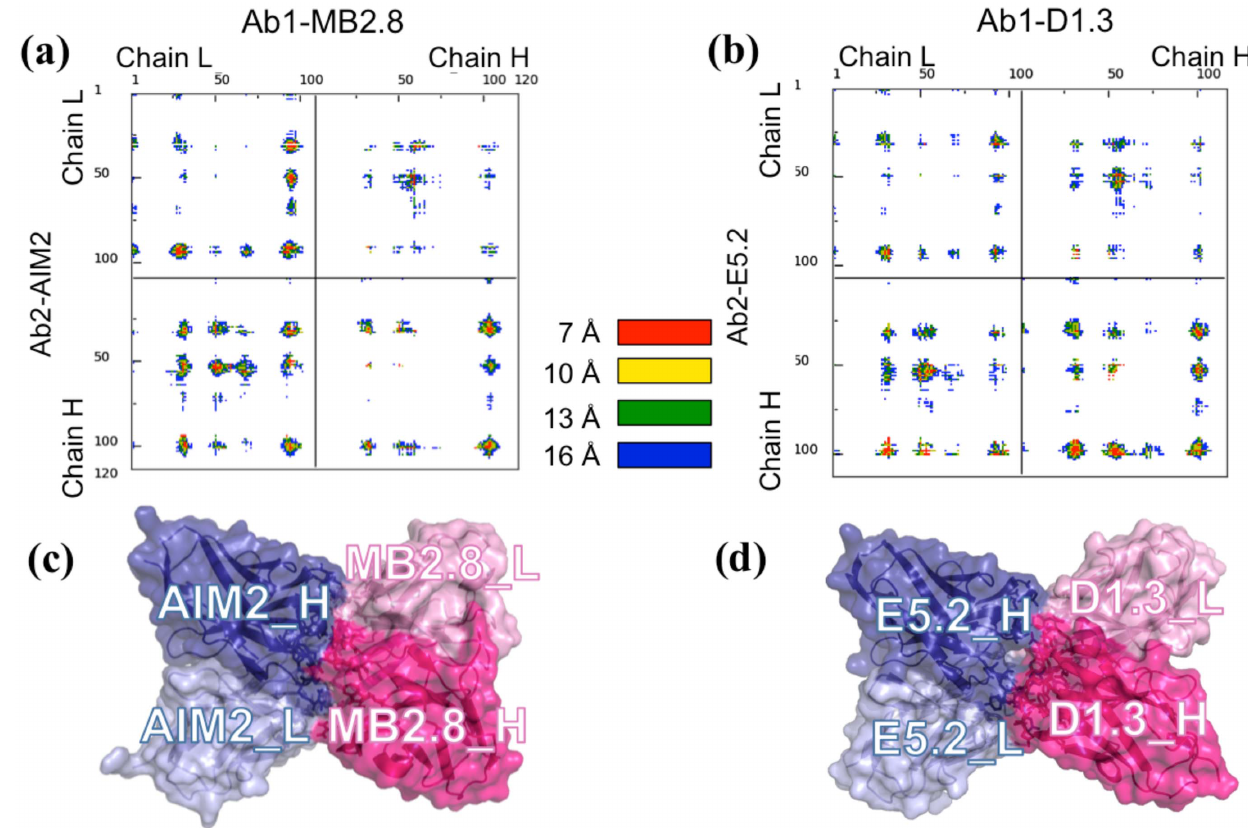
Figure 4. Comparison between M1-CDR and the X-ray structure of the D1.3-E5.2 Ab1-Ab2 complex (1DVF). ( a ) and ( b ): the distance range contact maps by COCOMAPS [30], calculated for the MB2.8-AIM2 model ( a ) and the experimental structure of E5.2/D1.3 complex (PDB code: 1DVF) ( b ). The dots at the crossover of two residues are colored in red, yellow, green and blue if any pair of atom is closer than 7, 10, 13 and 16 A˚, respectively. ( c ) and ( d ): Pymol [70] visualization of MB2.8-AIM2 model ( c ) and the experimental structure E5.2-D1.3 ( d ). The color code is the same in both figures: the Ab1 light and heavy chains are colored in light and dark blues, respectively; the Ab1 light and heavy chains are colored in light and dark pink, respectively. Labels have been added for the Ab1’s and Ab2’s light and heavy chains.